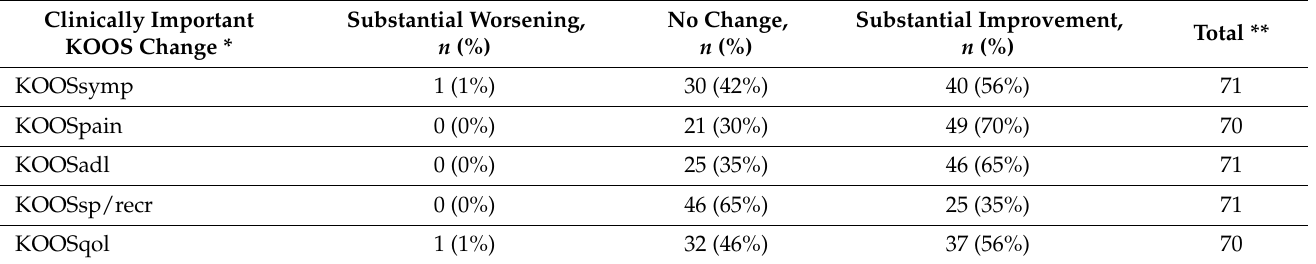
Table 3. Substantial clinical benefit (SCB) in Knee Injury and Osteoarthritis Outcome Score (KOOS) subscales at 12-month follow-up after total knee